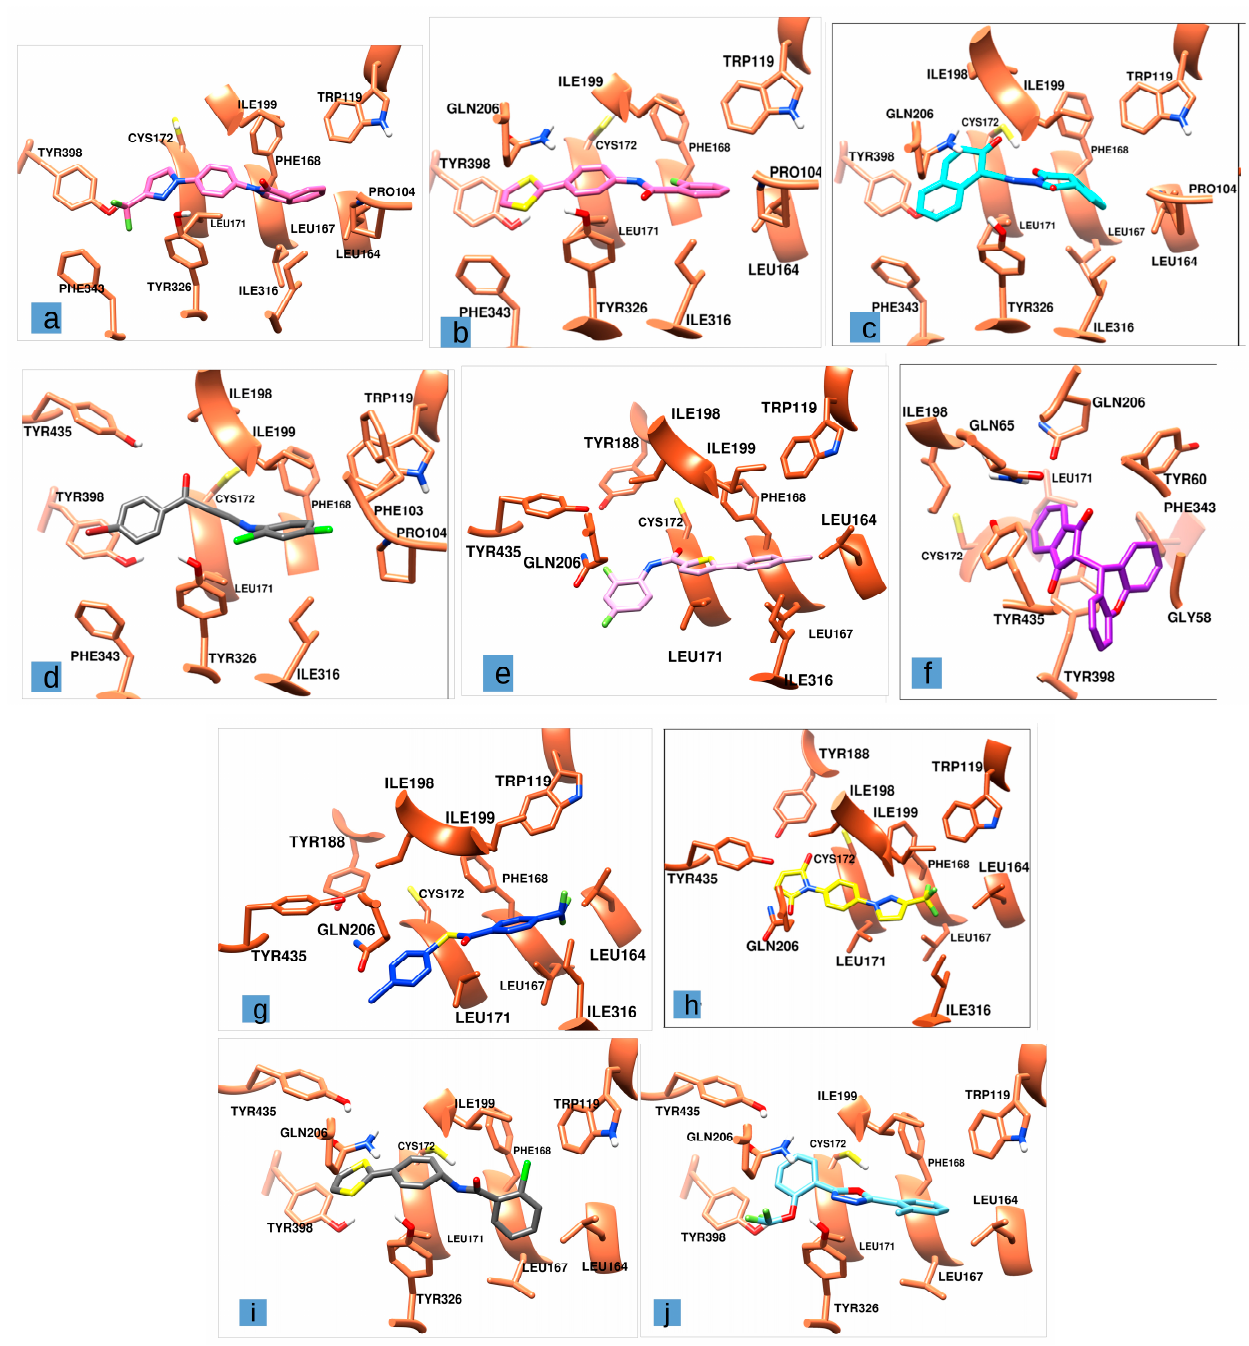
Figure 9. Panels image ( a – j ) show the residues involved in interactions with compounds 1 – 10 , respectively.